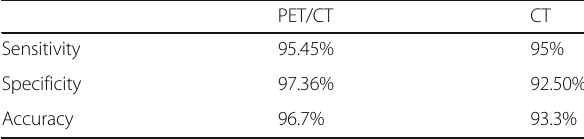
Table 2 Comparison between sensitivity, specificity, and accuracy of PET/CT and CT regarding local